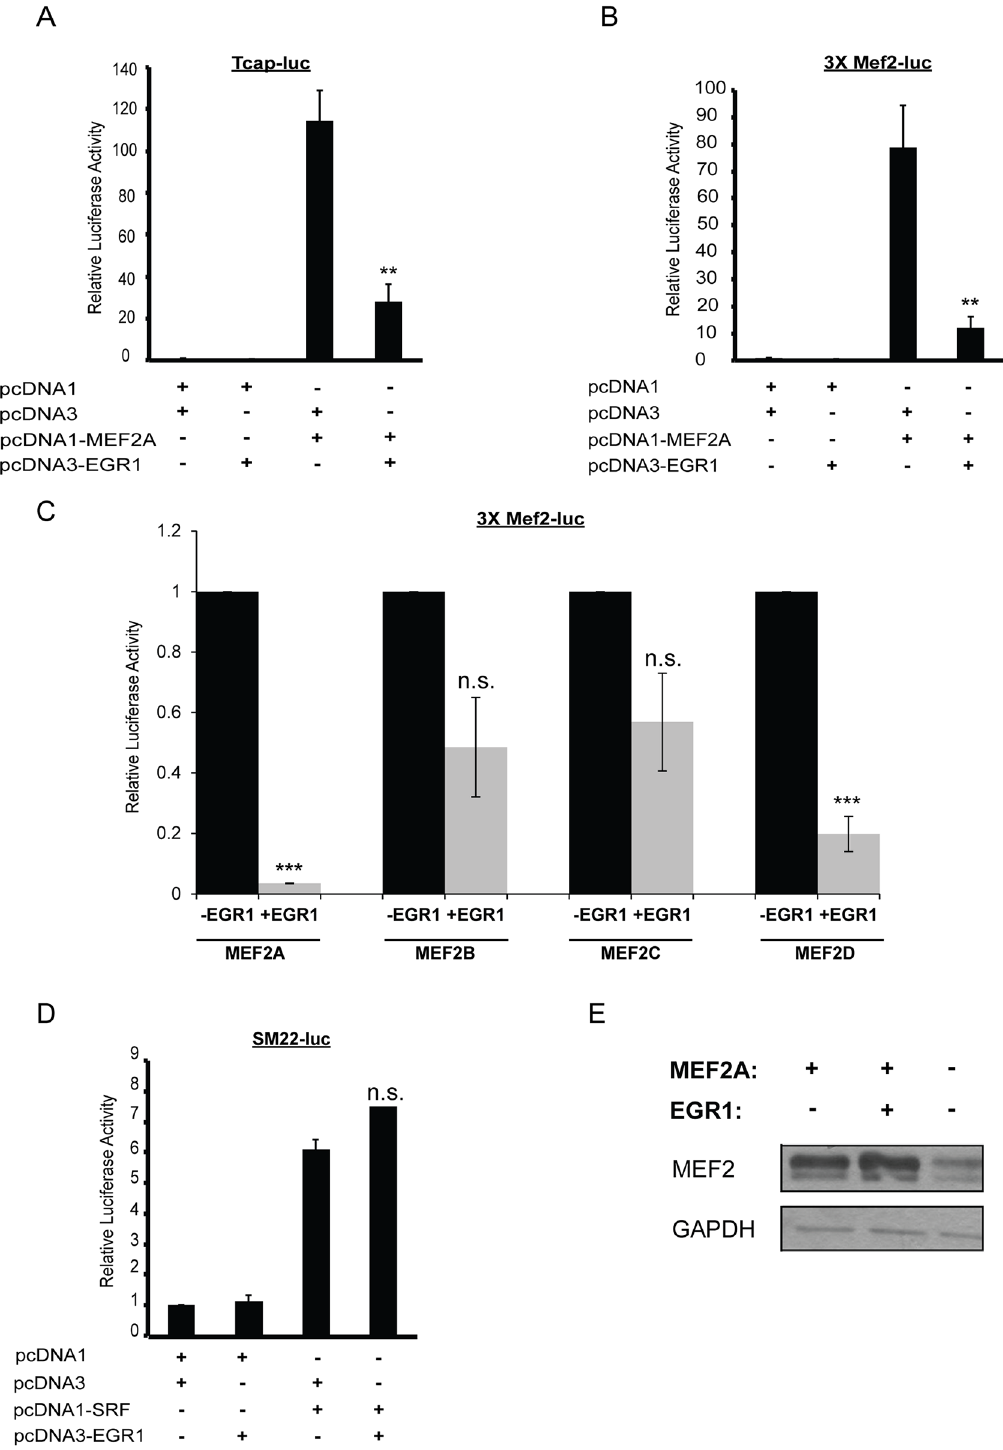
Fig 1. EGR1 is a potent repressor of MEF2 transcriptional activity. (A) EGR1 represses MEF2A transcriptional activity. HEK293T cells were transfected with the Tcap -Luc, pcDNA3-EGR1 and pcDNA1-MEF2A. pcDNA1 and pcDNA3 were used as empty plasmid controls for the MEF2A and EGR1 expression vectors, resepectively. Firefly luciferase readings were normalized by Bradford assay. (n = 6, p < 0.003). (B) Western blot analysis shows that EGR1 overexpression does not decrease the expression of MEF2A. (C) HEK293T cells were transfected similarly to as in Panel A, but instead with the 3xMEF2-luc reporter vector. (n = 4, p < 0.007). (D) EGR1 represses transcriptional activity of MEF2A and MEF2D, and there is a non-significant repressive trend